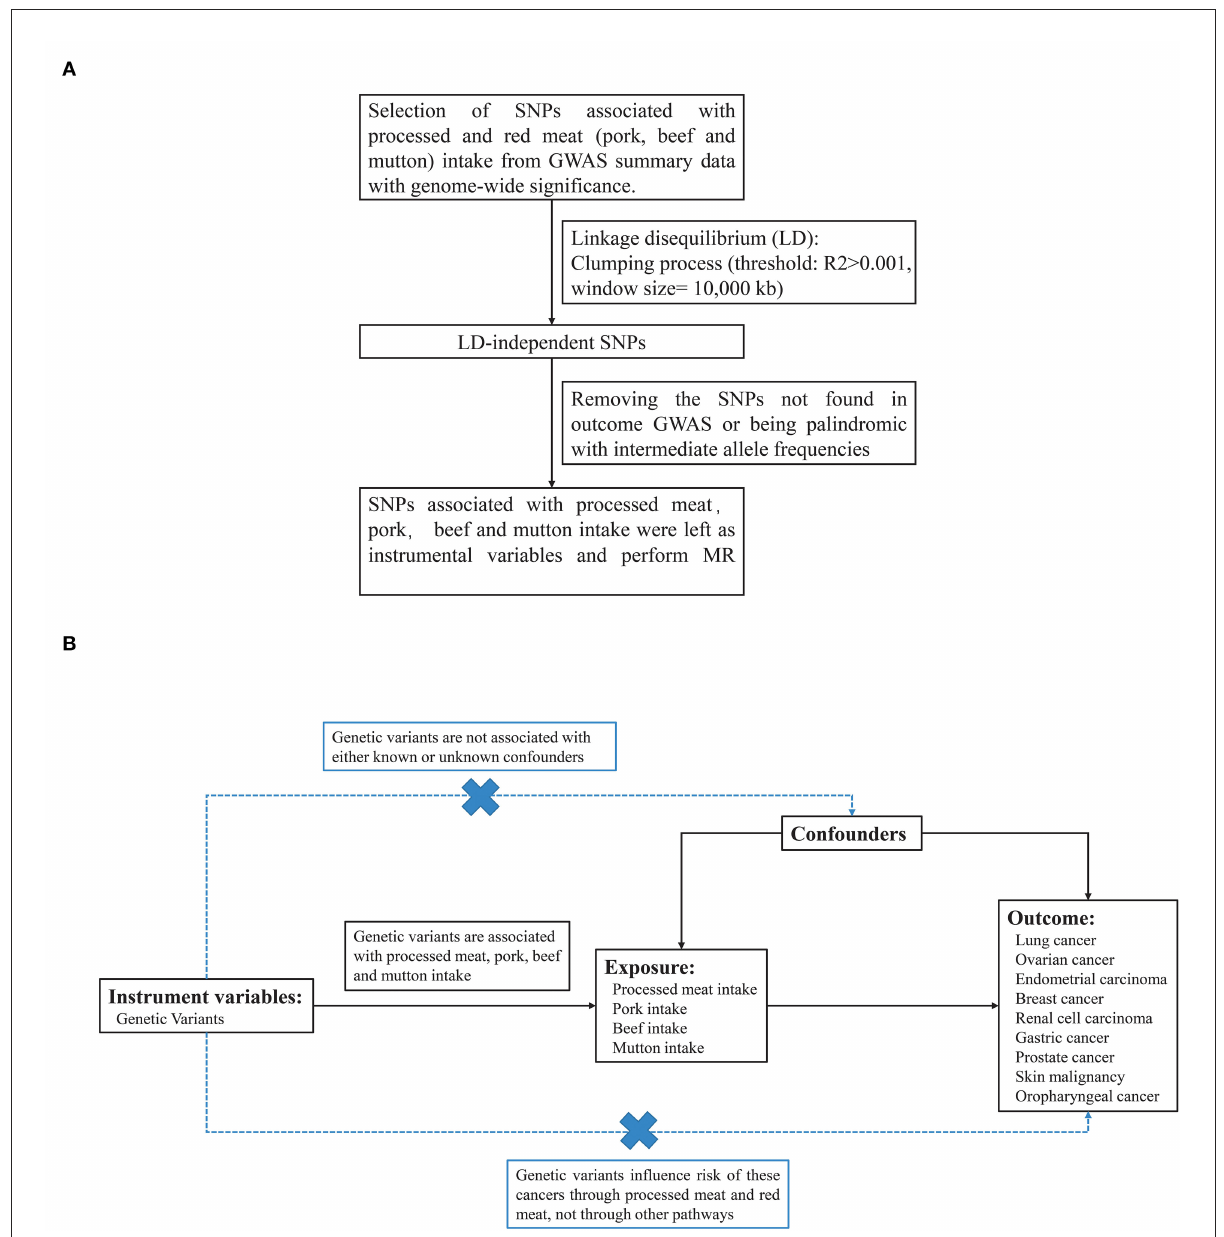
FIGURE1 (A) The design of MR analysis in our study. (B) The flow chart about the process of screening for SNPs associated with